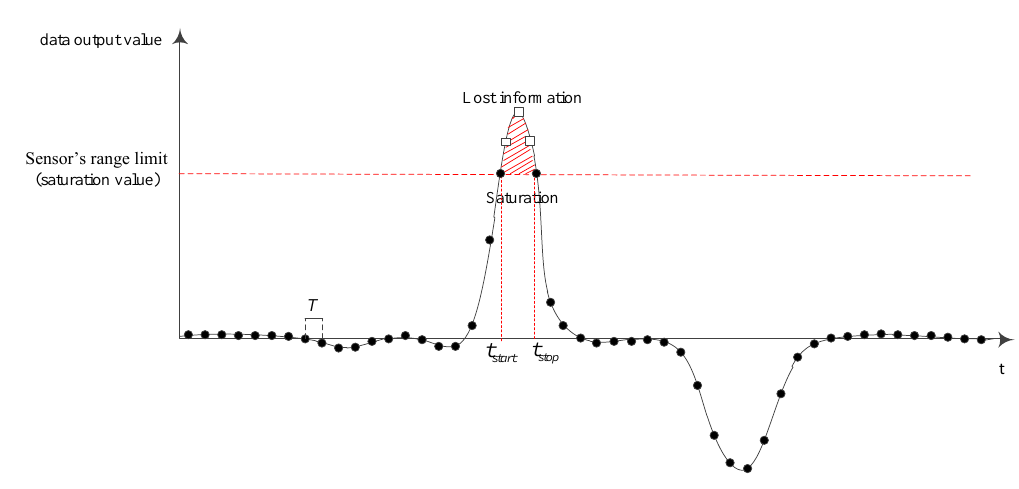
Figure 2. Sensor